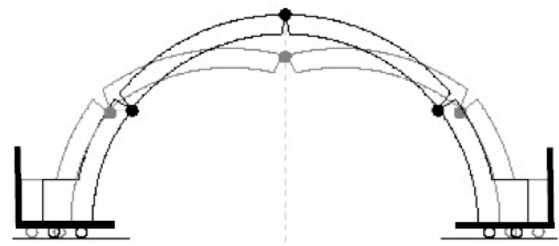
Figure 5. Settlement of the arch.